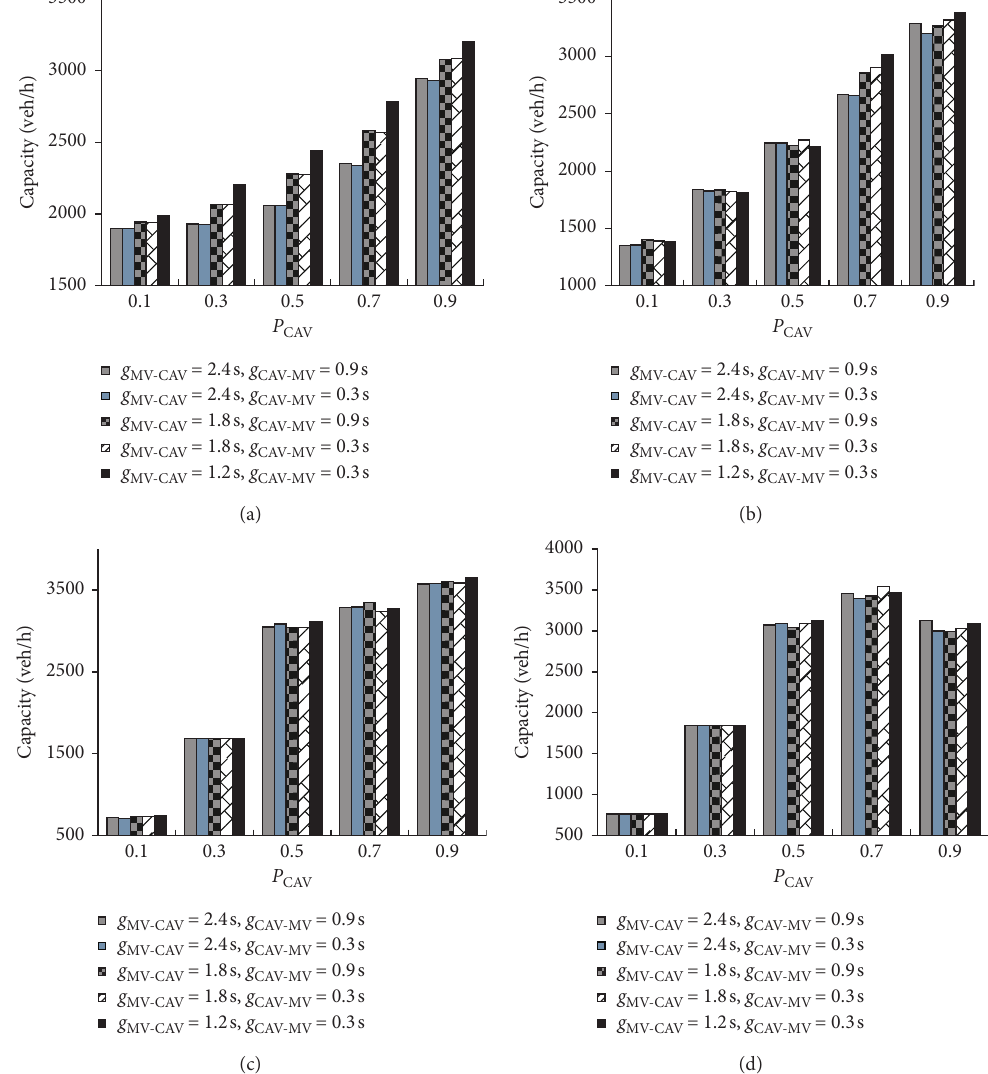
Figure 7: Relationship between capacity and CAV penetration rate with different g (d)